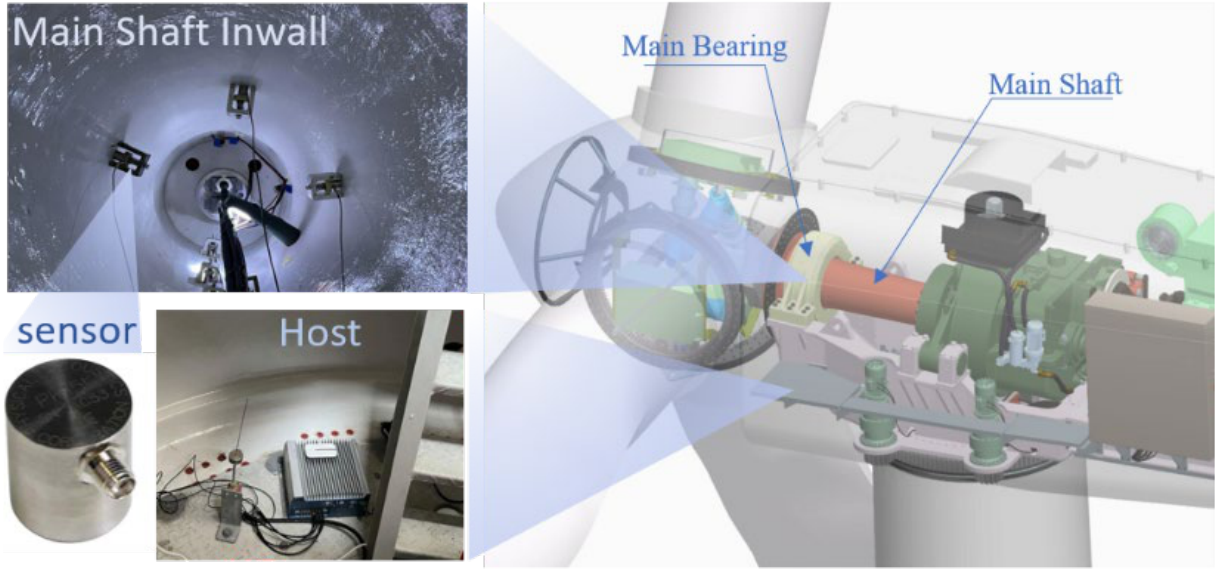
Figure 6. The wind turbine spindle bearing on-line experimental setup.